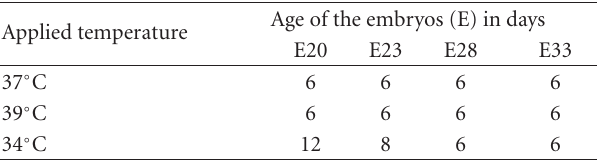
Table 1: Number of embryos investigated in each age group (E20 to E33) under control conditions (37.5 ◦ C), acute cold stimulation (34 ◦ C for 3 hours before experiment), and acute warm stimulation (39 ◦ C for 3 hours before